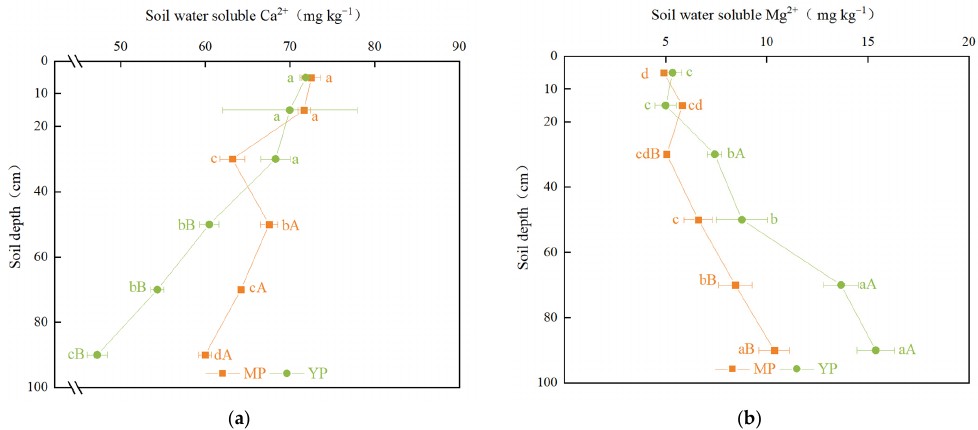
Figure 6. Changes of soil water-soluble Ca 2 + ( a ) and Mg 2 + ( b ) along 0 − 100 cm soil profiles in the mature (MP) and young poplar (YP) plantations. Different lowercase letters denote significant dif- ferences among different depths within the same plantation; while different uppercase letters de- note significant differences between different plantations within the same soil depth ( p < 0.05).